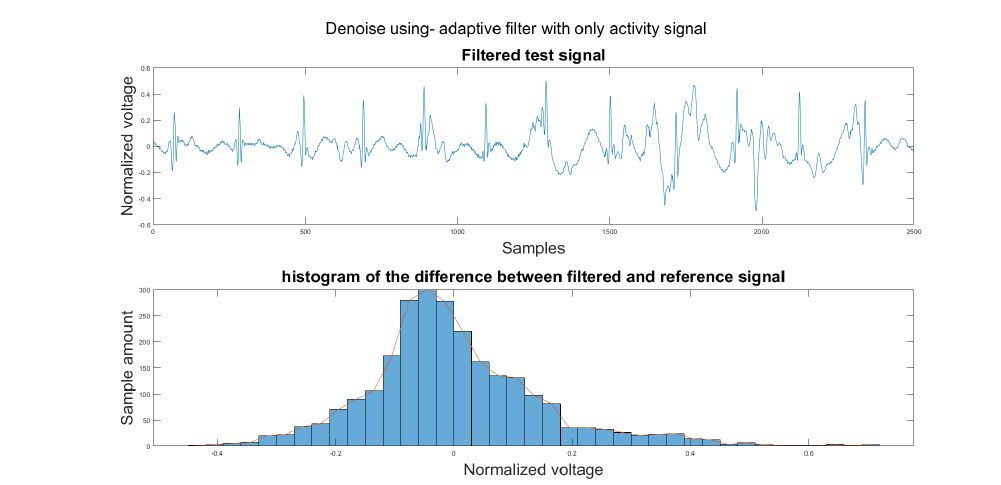
Figure A20. (1) Test signal, (2) histogram of the